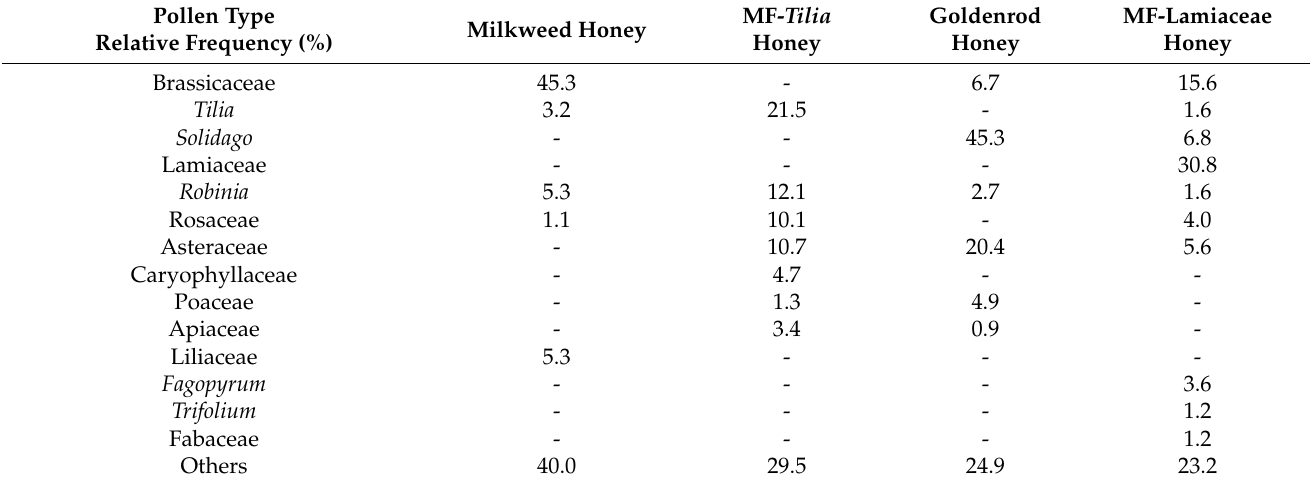
Table 2. Pollen spectrum of the studied